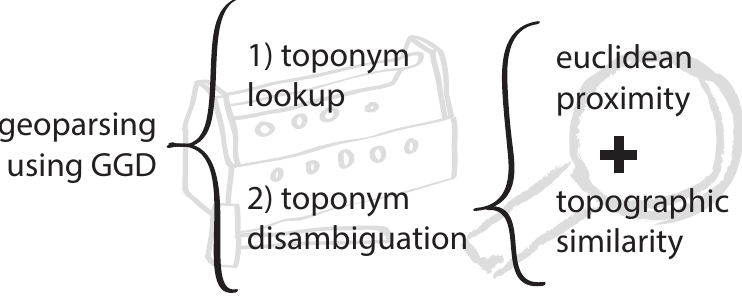
Figure 6: Sketch of the components and the functionality of